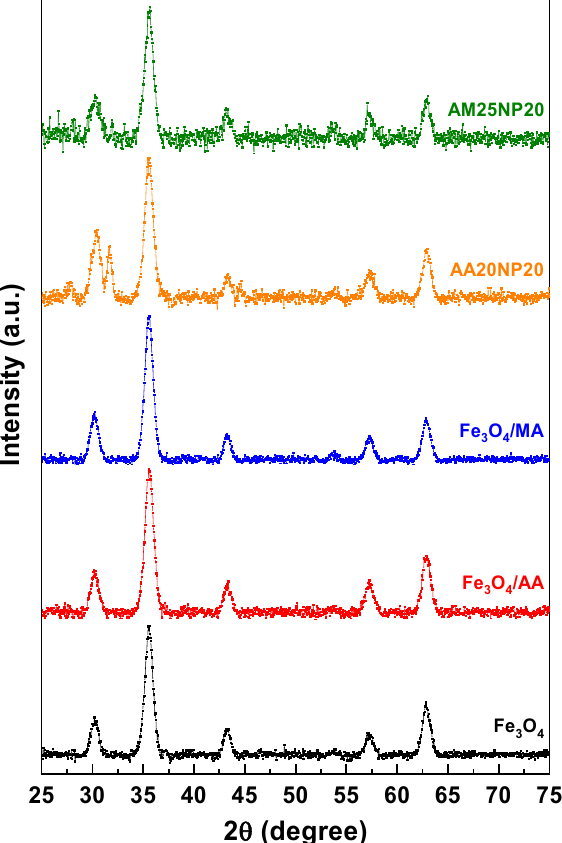
Figure 1. X-ray diffractograms of pure Fe 3 O 4 nanoparticles (Fe 3 O 4 ), acrylic acid, and methacrylic acid surface-modified Fe 3 O 4 nanoparticles and magnetic poly(vinyl pivalate) nanocomposites (i.e., AA20NP20 and AM25NP20).